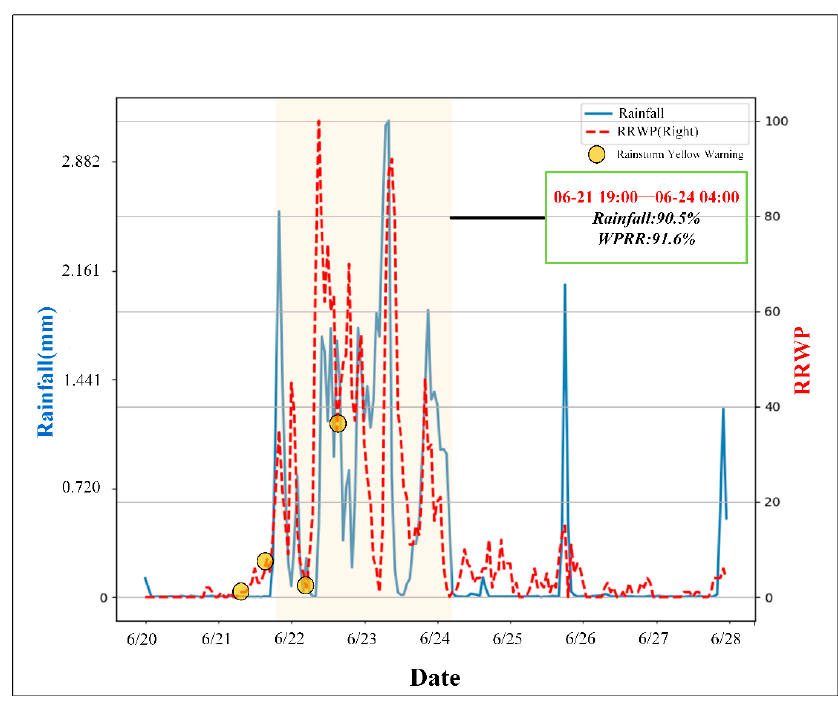
Figure 6. Time series of hourly accumulated rainfall and Weibo posts.